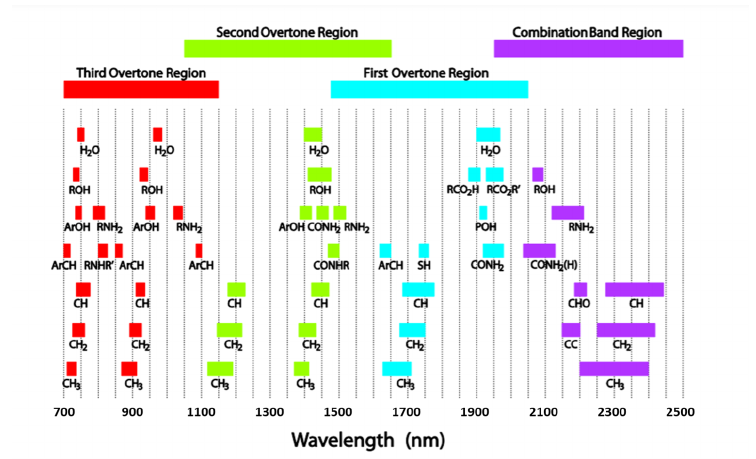
Figure 5. Major analytical bands and relative peak positions for prominent NIR absorptions [68].